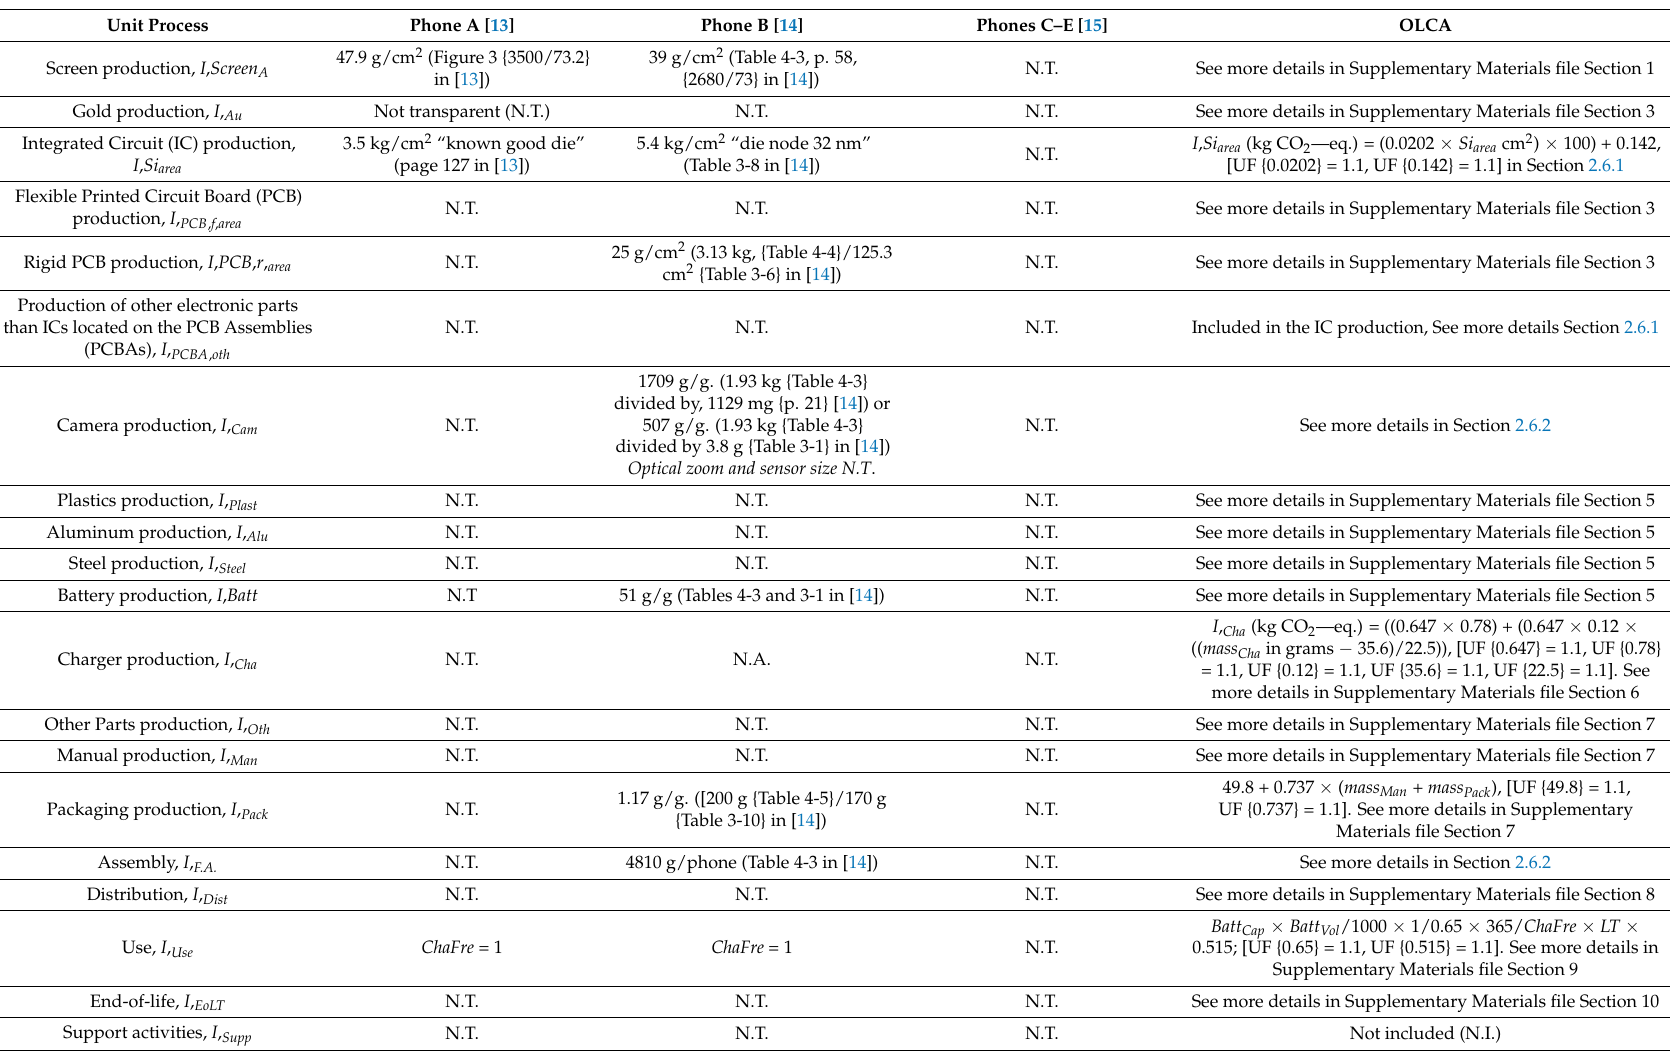
Table 5. CO 2 —eq. intensities and values used in FLCAs of Phones A and B and in OLCA. Unit Process Phone A [13] Phone B [14] Phones C–E [15]